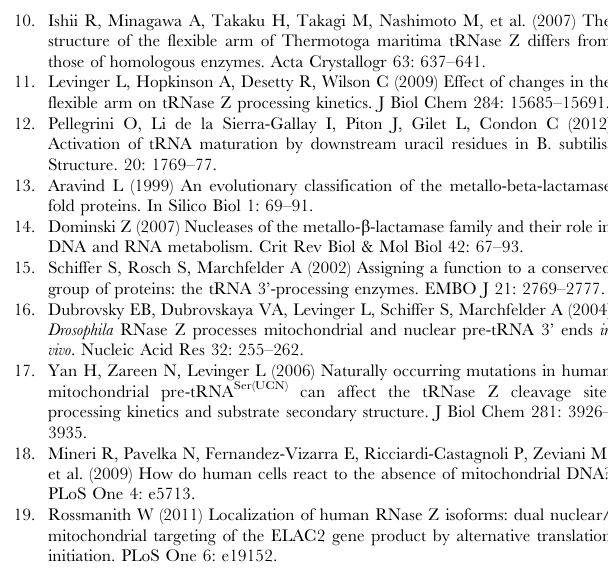
Figure SF4. Figure SF5. Detail views of tRNase Z FA free and bound to tRNA. Figure SF6. D. melanogaster tRNase Z– LysC & GluC MALDI-ToF. Tables ST6, ST7. Polypeptide Tables based on spectra in Supplemental Figure SF6. Table ST8. H. sapiens tRNase Z L – Trypsin MALDI-ToF Table. Figure SF7. H. sapiens tRNase Z L – Trypsin Full Length Coverage. Table